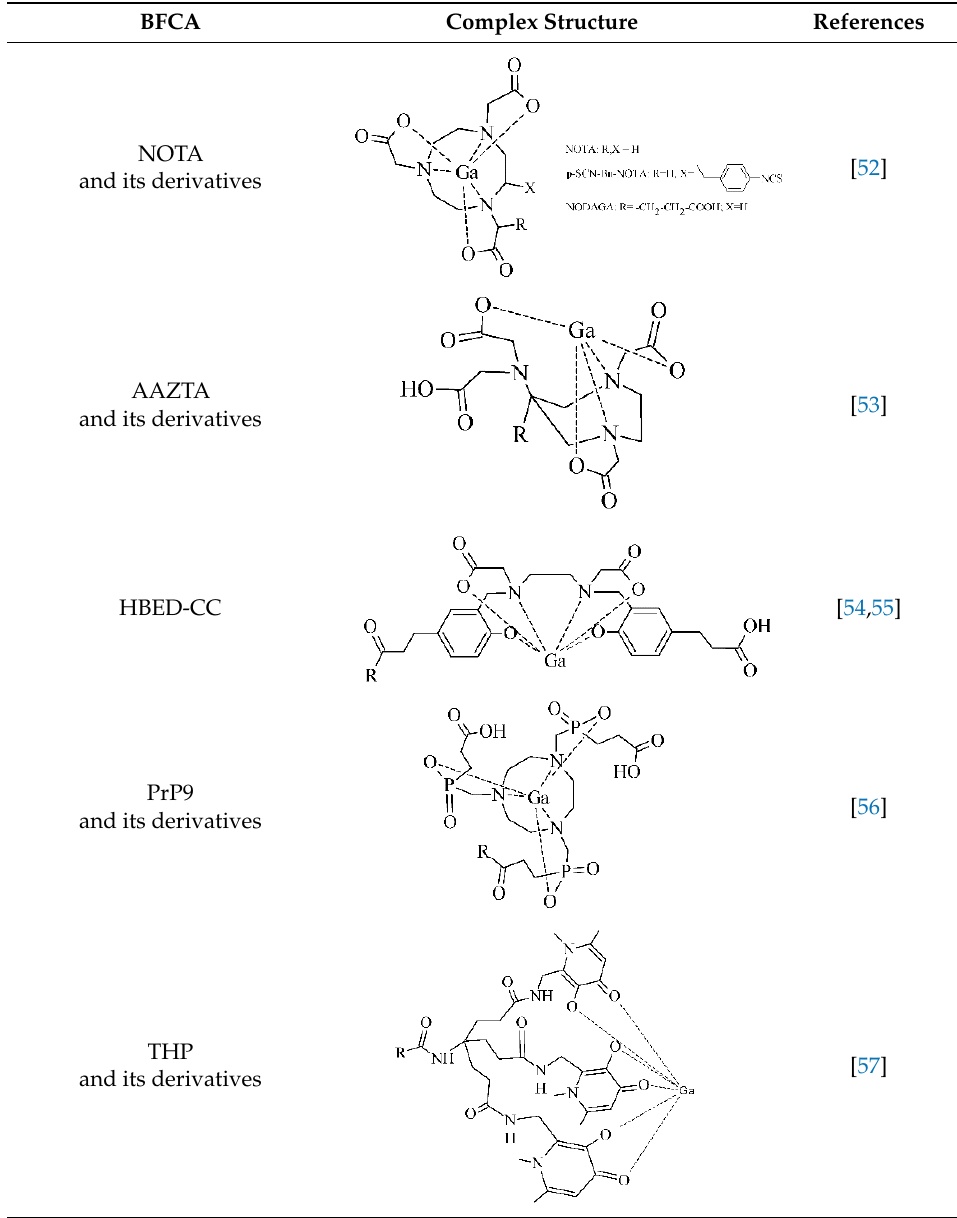
Table 4. The most common BFCA for 111 In-labeled compounds. BFCA Complex